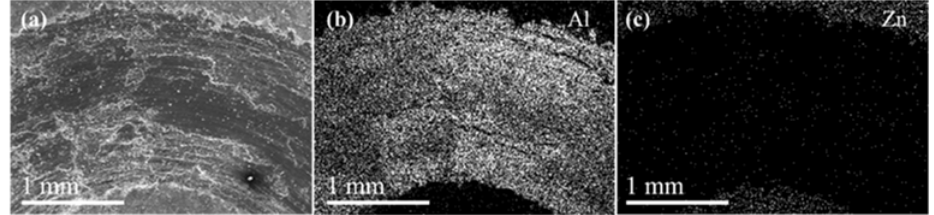
Figure 6. SE ‐ SEM micrograph ( a ) coated nanocomposite sample wear. Elemental mapping of the coating after wear test: ( b ) Al and ( c ) Zn.